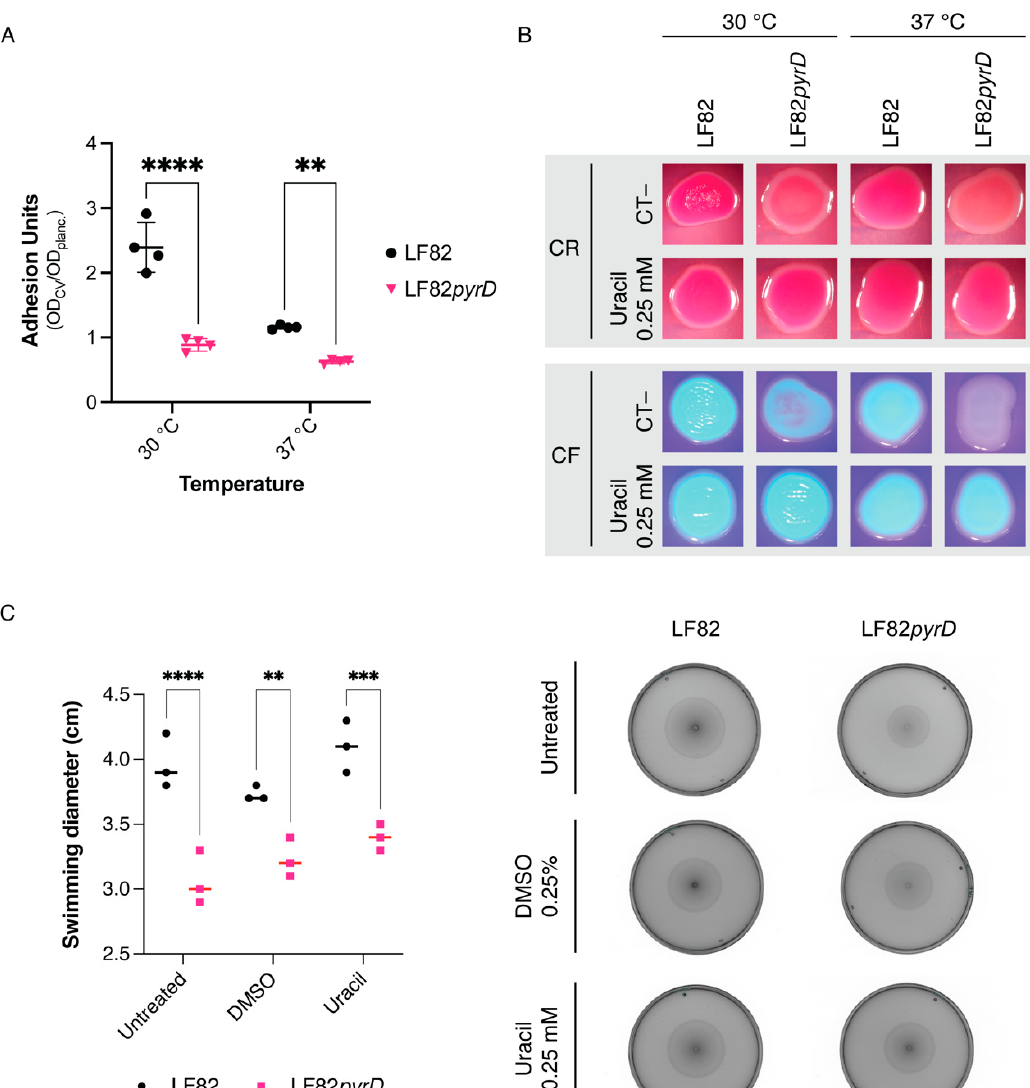
Figure 2. ( A ) Biofilm formation, measured as surface adhesion to polystyrene microtiter plates, using the Crystal violet method. Cultures were grown overnight in Yeast extract/Casamino acid (YESCA) medium at either 30 °C or 37 °C. Results of four independent values and median are shown. **, p -value < 0.01; ****, p -value < 0.0001, One-way ANOVA with Tukey’s test for multiple comparisons; ( B ) LF82 and LF82 pyrD:: Tn5 (LF82 pyrD ) phenotypes grown either at 30 °C or 37 °C on YESCA medium, either with or without uracil supplementation, in the presence of either Congo red (CR) or Calcofluor (CF); ( C ) Swimming motility on YESCA soft agar plates (typical experiment, right) and measurement of halo diameters (three independent experiments and median are shown, left). **, p -value < 0.01, ***, p-value < 0.001, ****, p -value < 0.0001, Two-way ANOVA with Šidák’s test for multiple comparisons.